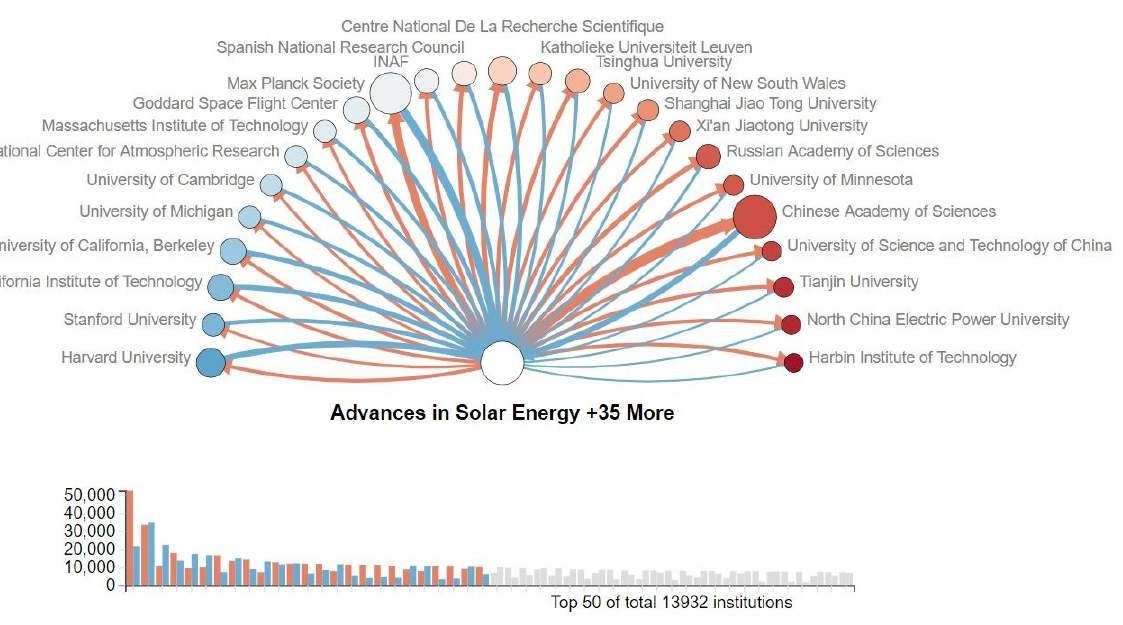
Figure 8. Influence flower visualizes publications and citations connections between organizations.